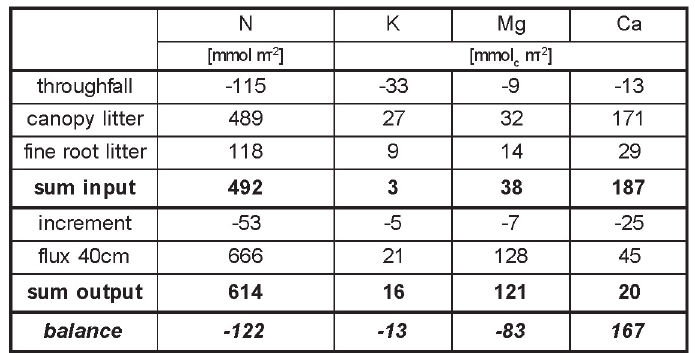
Differences in Nutrient Fluxes and Nutrient Losses from the Top 40 cm of Soil for the Clear-Cut Plot at Höglwald Compared to the Control